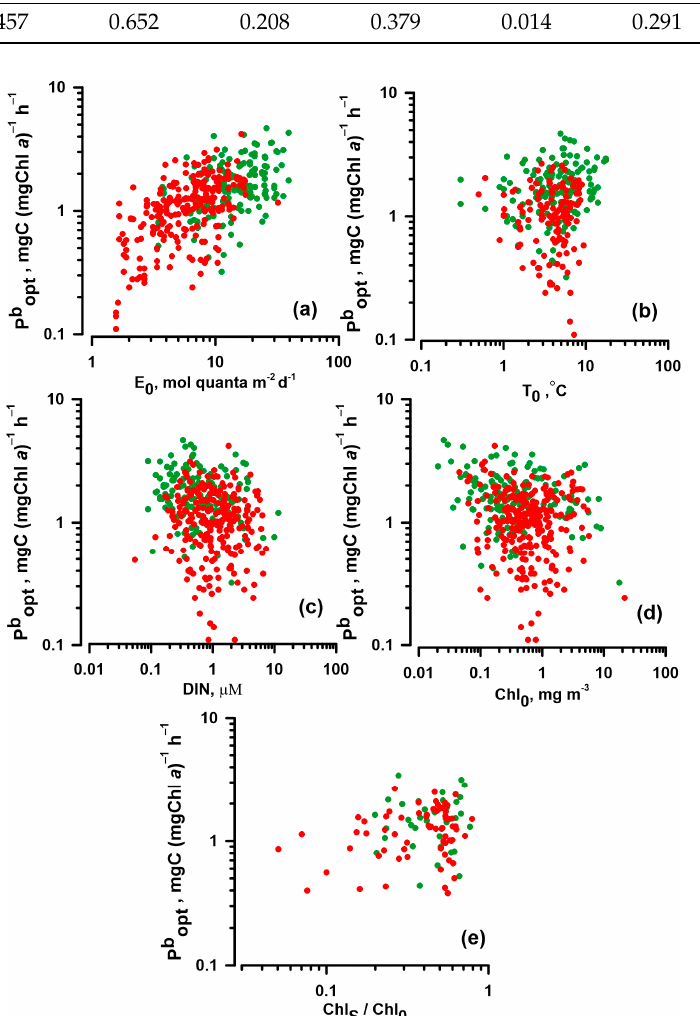
Figure 3. The relationships between the optimal assimilation number (P bopt ) and environmental factors. ( a ) Subsurface PAR (E 0 ); ( b ) sea surface temperature (T 0 ); ( c ) concentration of dissolved inorganic nitrogen (DIN); ( d ) surface chlorophyll a concentration (Chl 0 ); and ( e ) the ratio of chlorophyll a concentration of small (<3 μ m) to total surface phytoplankton (Chl s /Chl 0 ). Green and red colours indicate the measurements performed in the summer and autumn, respectively.